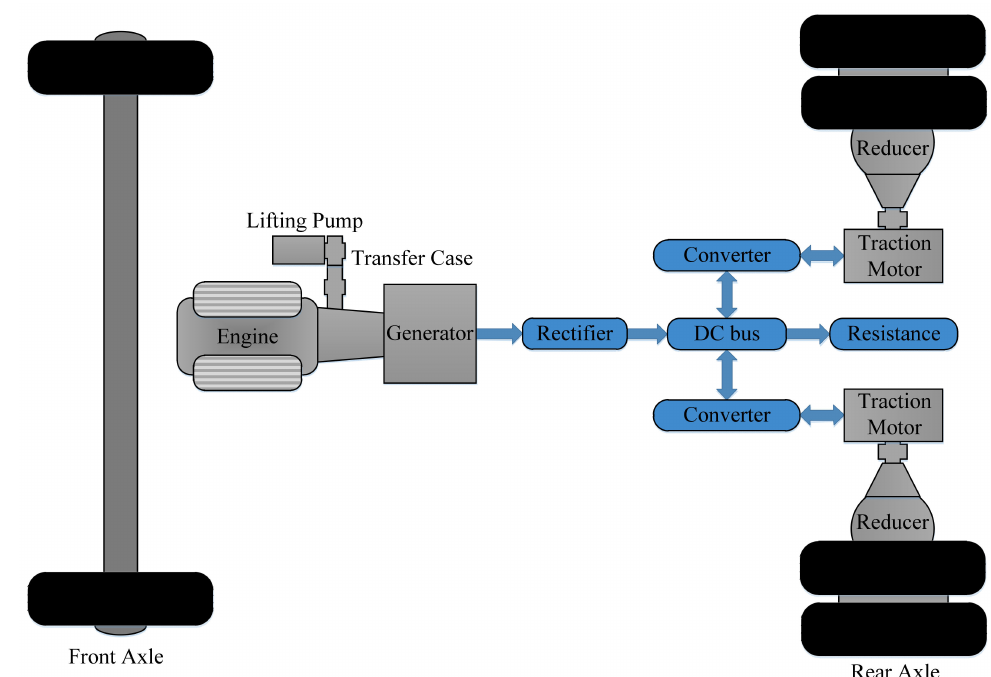
Figure 3. Powertrain of regular electric-drive mining